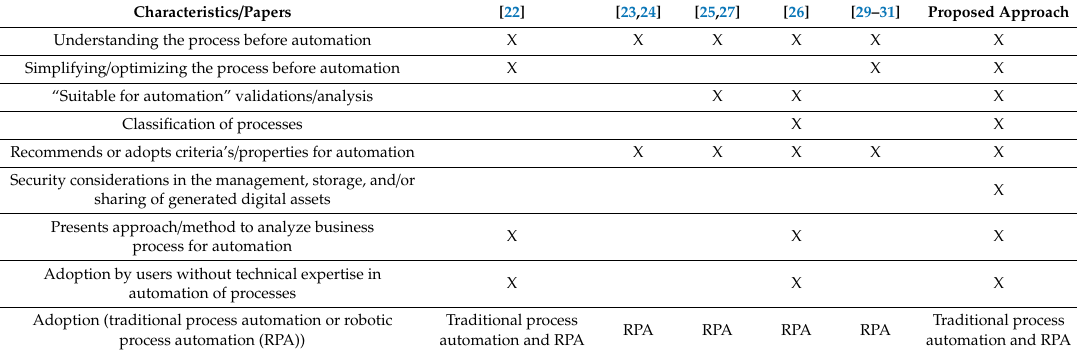
Table 1. Characteristics comparison of business process for